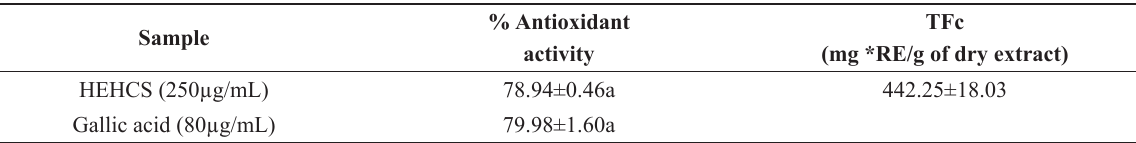
DPPH radical scavenging activity and total flavonoids content (TFc) of the hidroethanolic extract of Hymenaea courbaril seed (HEHCS).